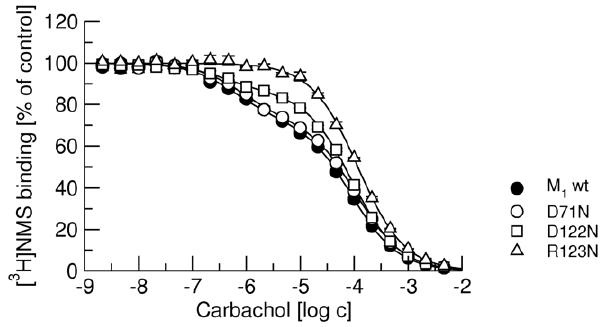
Figure 6. Effects of point mutations of the M 1 receptor on competition between carbachol and [ 3 H]NMS binding. Binding of 1 nM [ 3 H]NMS to membranes from newly prepared CHO cell lines expressing wild type and mutant M 1 receptors in the presence of increasing concentrations carbachol is expressed as per cent of control binding in the absence of agonist. Filled circles, binding to wild-type M 1 receptors. Open symbols, binding to D71N (circles), D122N (squares) and R123N (triangles) mutatant M 1 receptors. Data are means 6 S.E.M of values from 3 experiments performed in quadruplicates. Curves were fitted using equation 3 and results of fits are shown in Table 6.